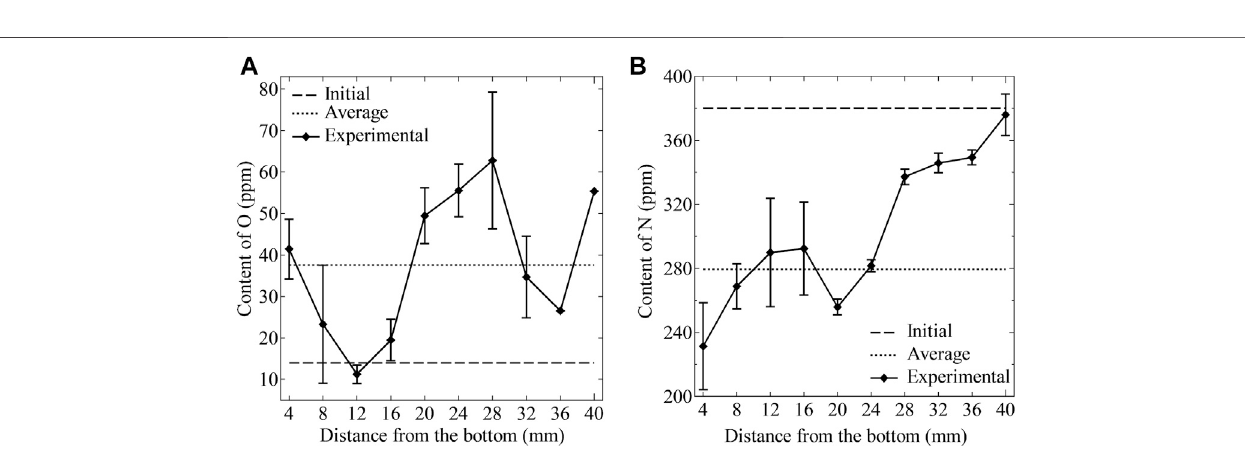
FIGURE 3 | Morphology and elemental mappings of complex inclusion of AlN-Al 2 O 3 .